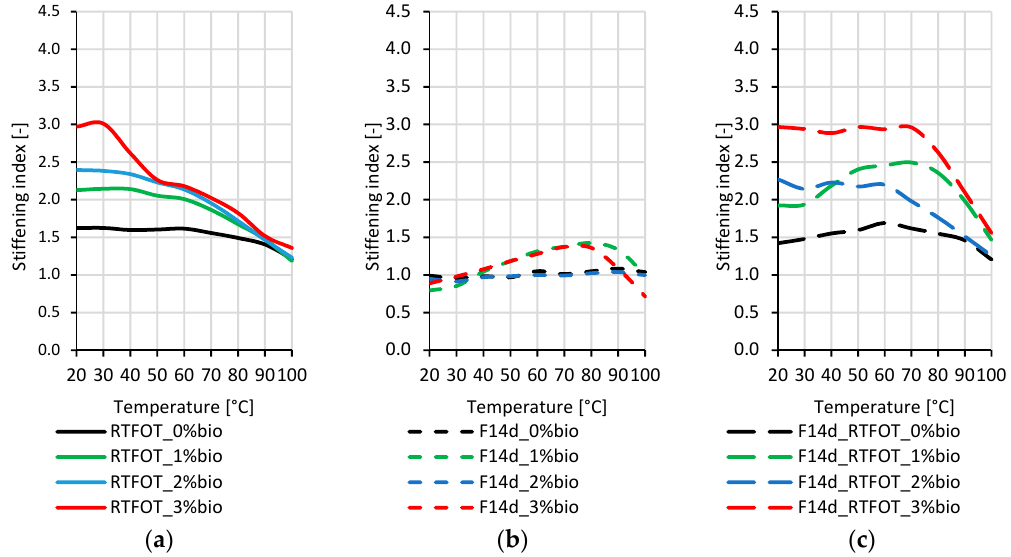
Figure 8. Stiffening index of the 45/80–55 polymer-modified bitumen: ( a ) non-foamed after RTFOT ageing bitumen (RTFOT); ( b ) foamed original bitumen (F14d); ( c ) foamed after RTFOT ageing bitumen (F14d_RTFOT).